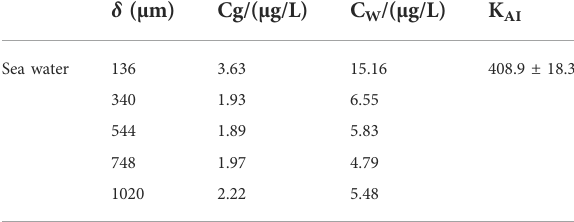
TABLE 3 Interface air-water partition constants of CN for sea water.